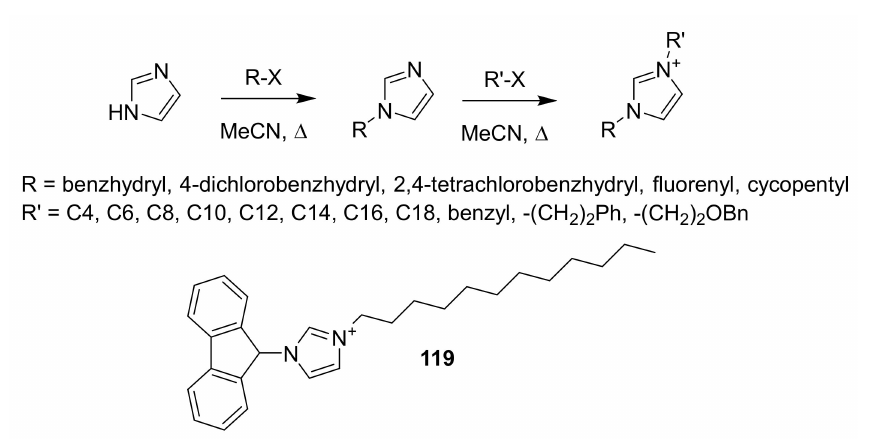
Scheme 16. Synthesis of N , N (cid:48) -alkylated